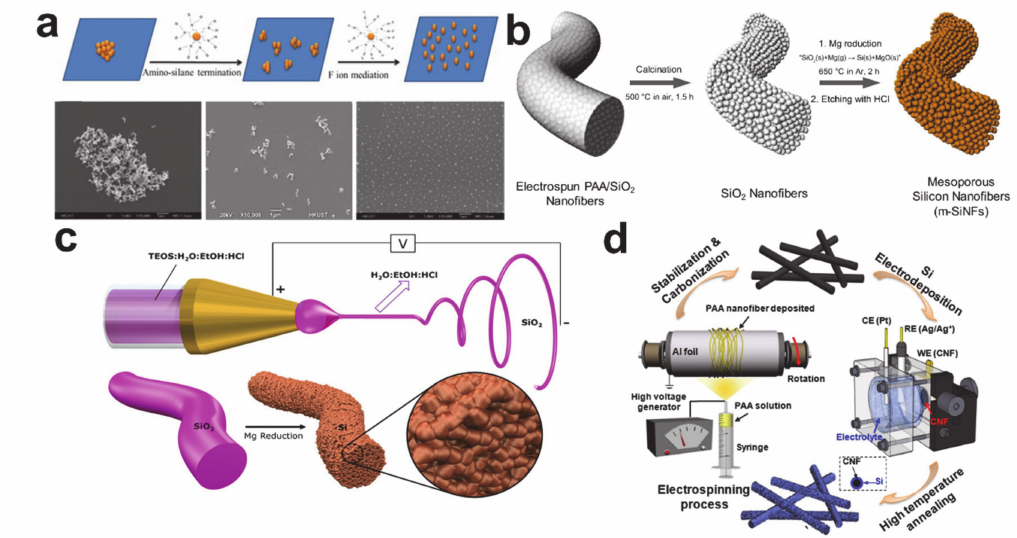
Figure 18. Schematic illustrations of various silicon sources and processing routes. ( a ) De-agglomerated Si nanoparticles (reprinted with permission from [211]; copyright 2014 Elsevier), ( b ) SiO 2 nanoparticle-based mesoporous silicon nanofiber (reprinted with permission from [212]; copyright 2013 American Chemical Society), ( c ) tetraethyl orthosilicate-based silicon nanofiber (reprinted with permission from [216]; copyright 2015 Springer Nature), and ( d ) SiCl 4 -based Si-coated carbon nanofiber (reprinted with permission from [218]; copyright 2014